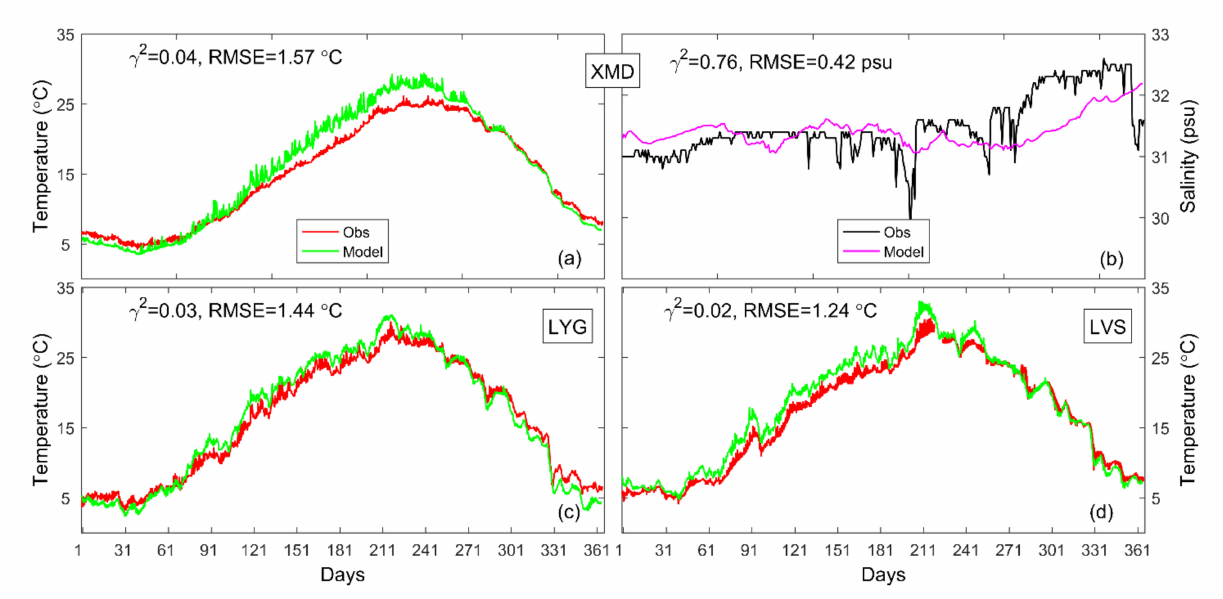
Figure 9. Time series of temperature ( a , c , d ) and salinity ( b ) at XMD, LYG and LVS stations based on observations provided by the NMDC and simulations produced by the inner model in the case of CR in